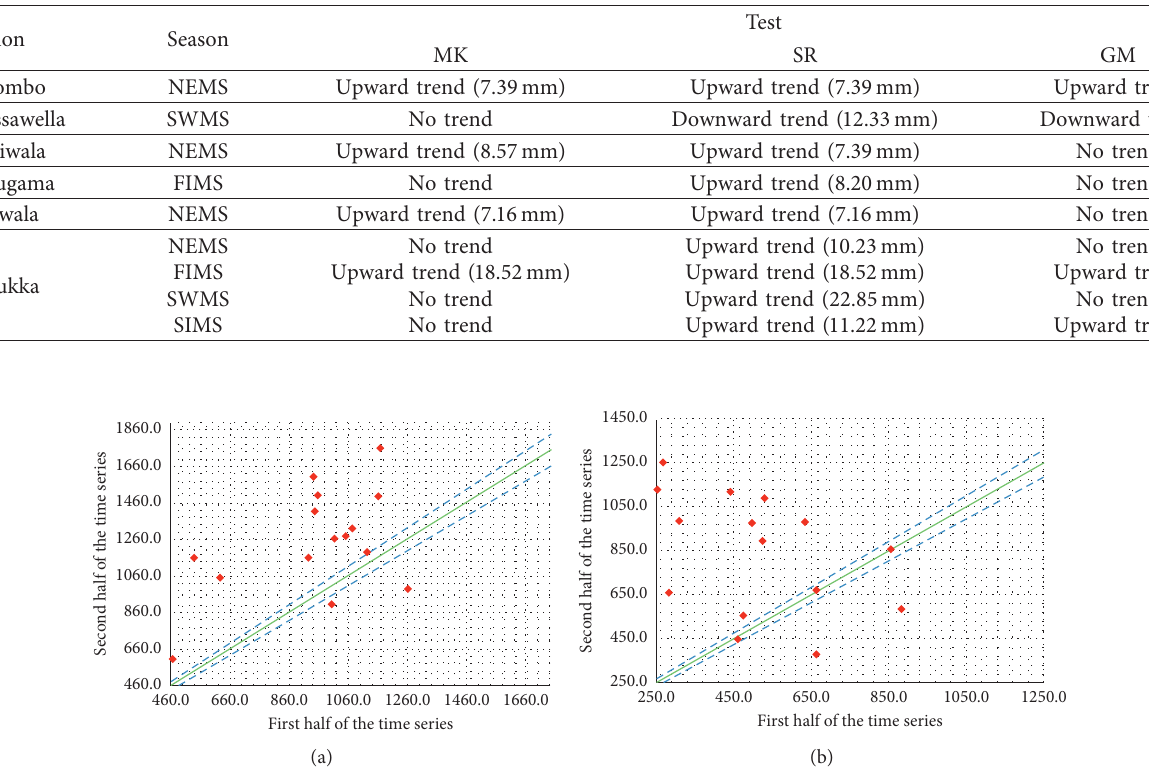
Figure 3: Trend analysis results using the graphical method for seasonal rainfall for Padukka (a) in SIMS and (b) in